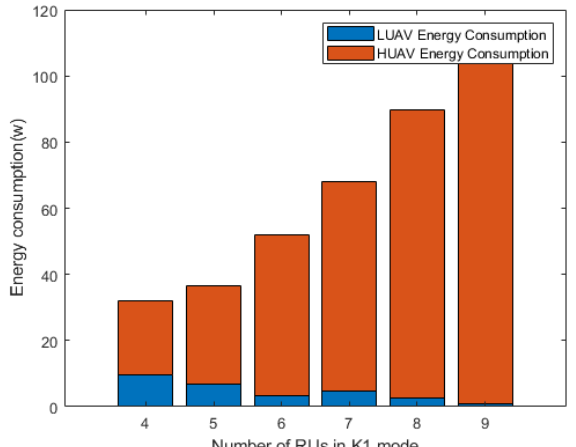
Figure 5. Relationship between the number of RUs selecting K1 mode and the energy consumption proportion of upper and lower unmanned aerial vehicles.